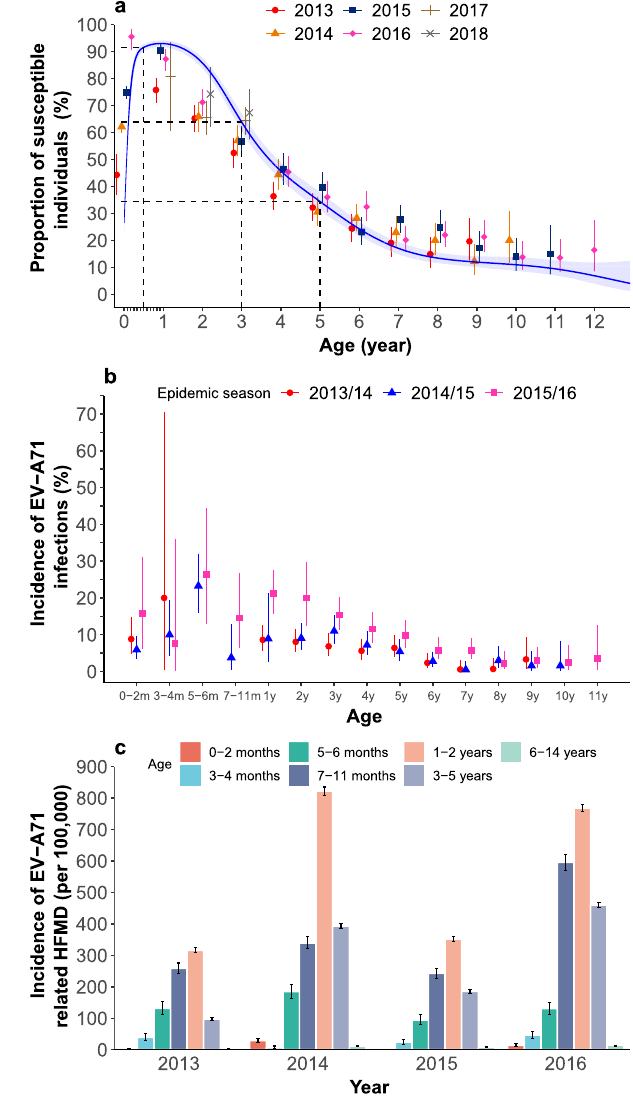
Fig.2|TheproportionofsusceptiblepopulationsandnewinfectionsofEV-A71 (a cutoff titre of 16) and incidence of EV-A71 – related hand, foot, and mouth diseases by age and season. a Age-speci fi c proportion of susceptible populations for all study participants in Children and Neonate cohort (points represent observedmeanproportion;bluecurverepresents fi ttedmeanproportion,whereas blue shadow represents corresponding 95% CI; the ticks between label 0 and 1 on x-axis represent 1 – 11 months of age). b Age-speci fi c incidence of EV-A71 infections identi fi edbyserologyforthosestudyparticipantswithpairedserabeforeandafter HFMDepidemics 23 .Inthex-axis, “ m ” representsageinmonths, “ y ” representsagein years. Error bar represents corresponding 95% CI. *Age at the fi rst blood draw for thepairedsera. c Incidenceof EV-A71-associatedhand,foot,andmouthdiseasesin Hunanprovincebyagegroup.Errorbarrepresentscorresponding95%CI.Note:the sample size of each panel was listed in Supplementary Table 9.